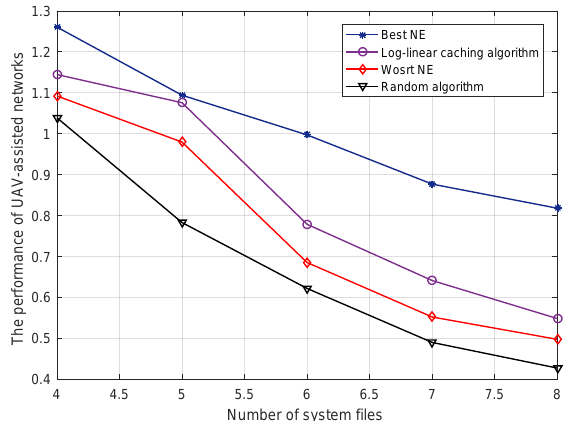
Figure 3. The performance of UAV-assisted networks versus the number of system files ( N = 8 and | c n | =